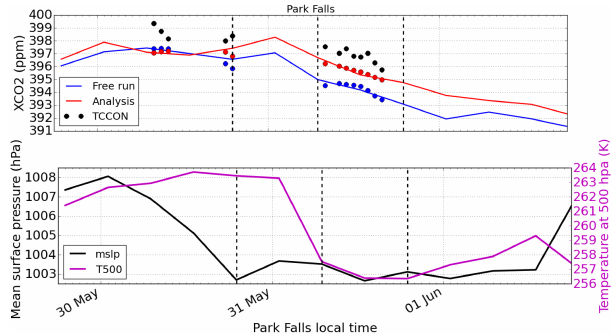
Figure 6. Situation over Park Falls (USA) between 30 May and 2 June. Top panel: evolution of XCO 2 (in ppm) from hourly aver- aged TCCON data (black dots), the free run (blue line and dots) and the analysis (red line and dots). The dots are the values of the model in the observation space. Lower panel: evolution of the mean sea level pressure (inhPa, black line) and the temperature at 500hPa (inK, magenta line). The vertical dotted lines represent 31 May, at 00:00UTC and at 12:00UTC, and 1 June, at